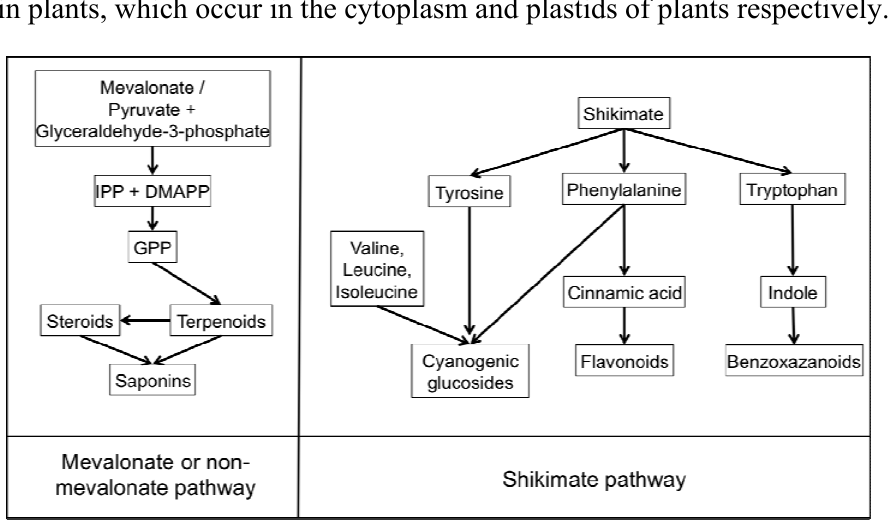
Figure 1. Simplified diagram illustrating the biosynthetic pathways of the discussed plant secondary metabolites involved in pathogen defence. Cyanogenic glucosides, flavonoids and benzoxazanoids are all synthesised from the aromatic amino acids derived from shikimate. Saponins and terpenoids are synthesised via the melavonate or non-melavonate pathway in plants, which occur in the cytoplasm and plastids of plants